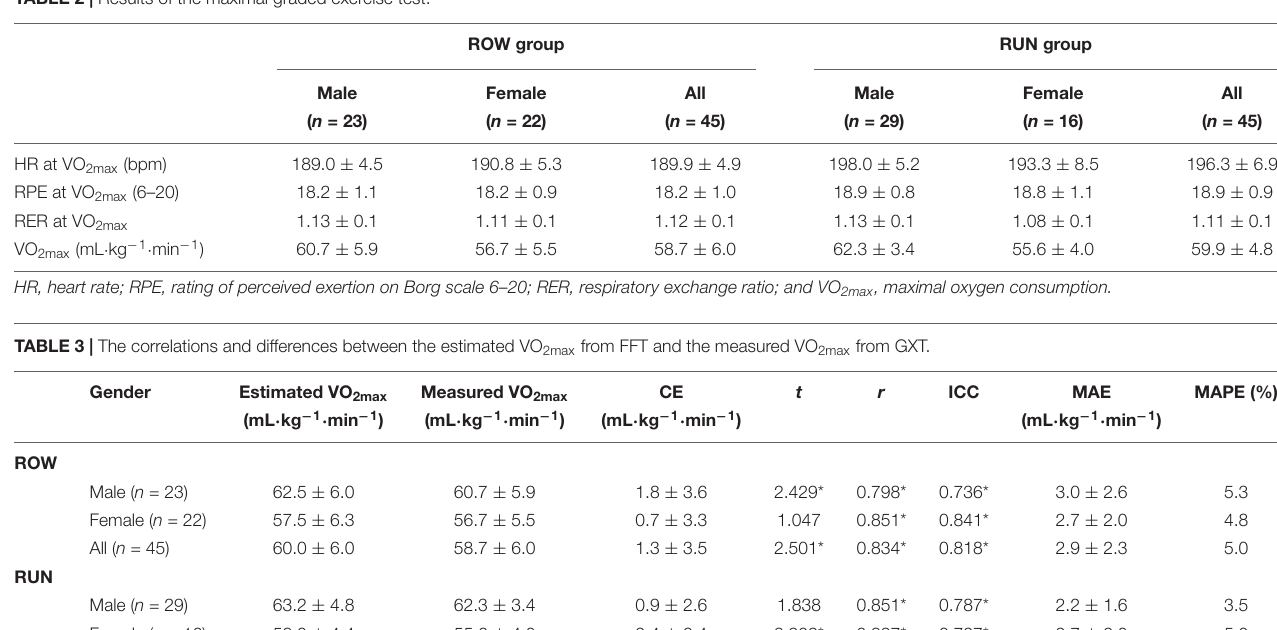
TABLE 2 | Results of the maximal graded exercise test.